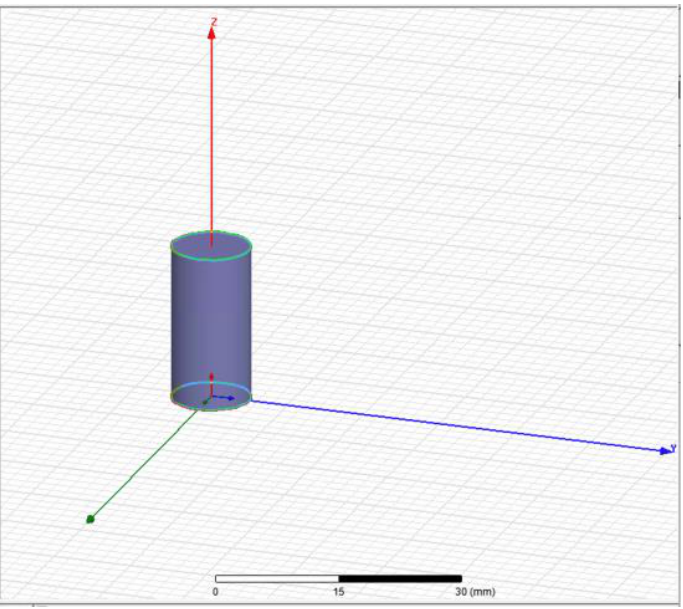
Figure 6. Modeling of a single cylindrical magnet.